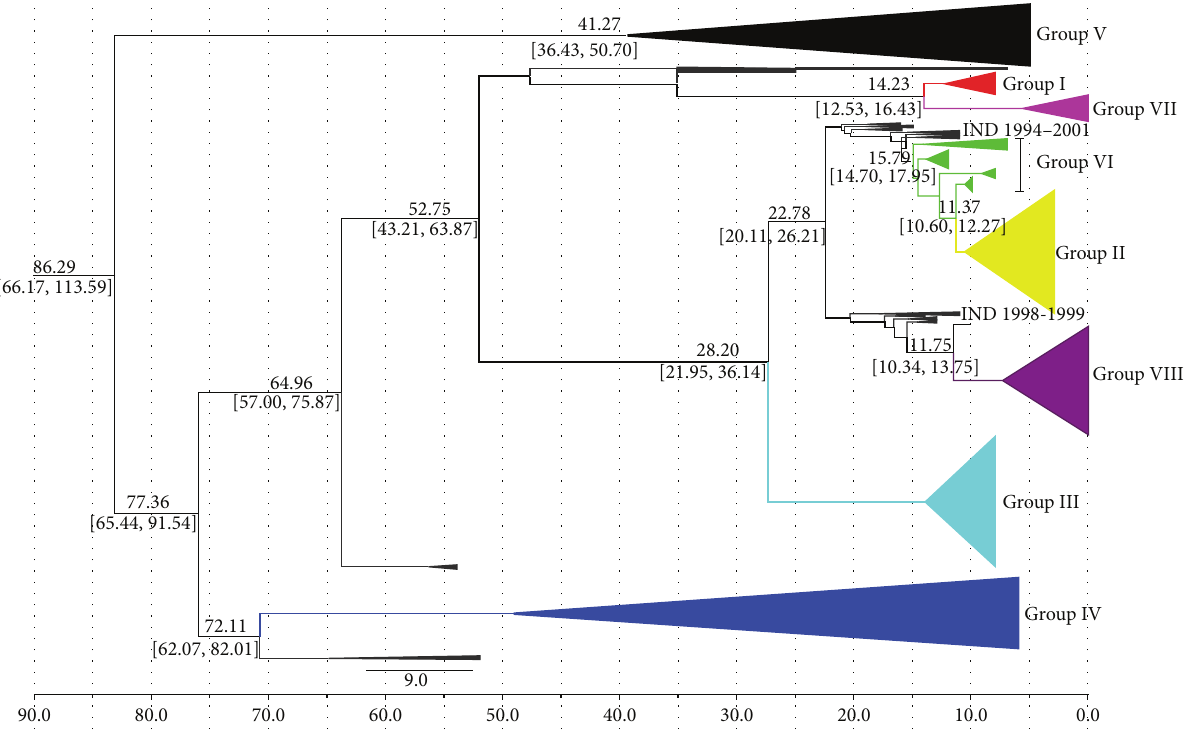
Figure 2: Chronogram and maximum clade credibility (MCC) tree of 3199 complete VP1 gene sequences of FMDV serotype Asia 1 generated using BEAST. The major eight groups (I–VIII) of viruses have circulated in Asia. The analysis demonstrates that mean divergence time estimates with 95% highest posterior density (HPD) credible intervals are shown in italics.